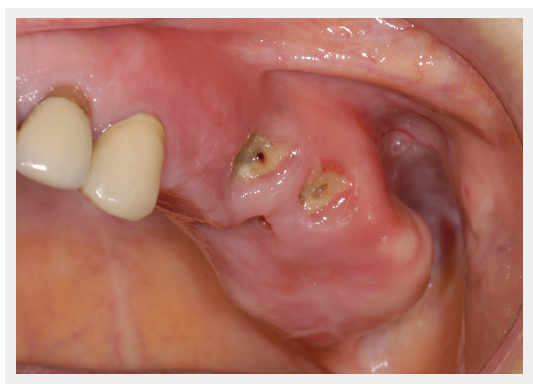
Figure 2 Female patient with osteoporosis and BRONJ of the left posterior maxilla including the maxillary sinus. The clinical picture shows exposed bone with signs of infection of the surrounding and pus